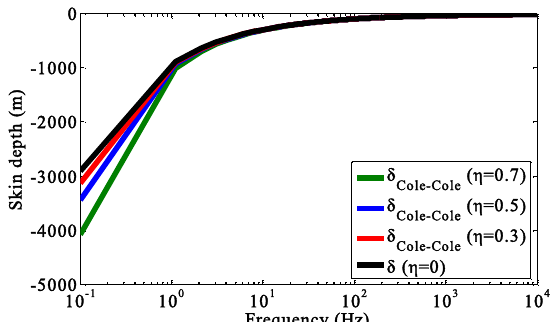
Figure 4. Skin depth of generalized polarized media at different chargeability values (black curve represents the traditional skin depth without polarization and red, blue, and green represent the generalized skin depth of polarized media with a chargeability of η = 0.3, η = 0.5, and η = 0.7, respectively).